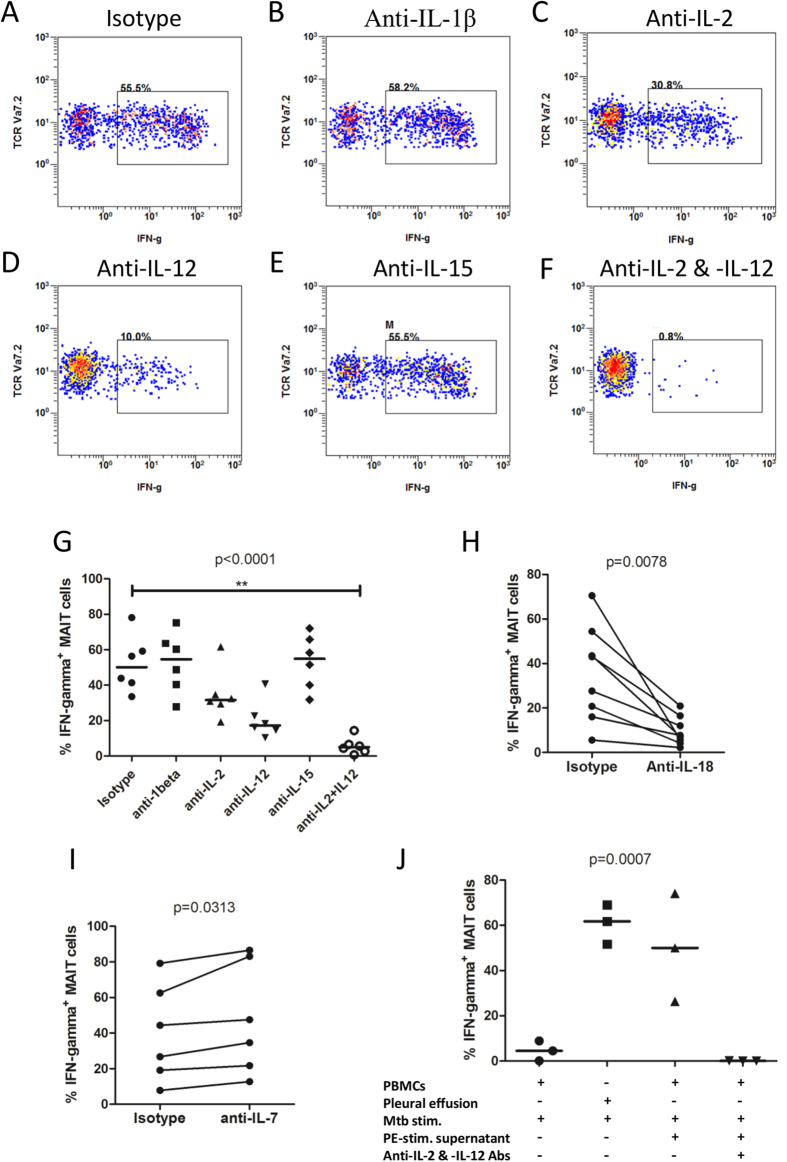
The role of cytokines on IFN-γ response of MAIT cells from tuberculous pleural effusions.(A–F) Representative flow plots showing IFN-γ production in Mtb-stimulated MAIT cells in the presence of isotype antibody control (A), or blocking antibody to IL-1β (B), IL-2 (C), IL-12 (D), IL-15 (E), or combined blocking antibodies of both IL-2 and IL-12 (F). (G) Reduced IFN-γ response in MAIT cells from tuberculous pleural effusions was observed when IL-2 and IL-12 were blocked with antibodies (n = 6). (H) Addition of IL-18 blocking antibody led to decreased IFN-γ production in MAIT cells (n = 8). (I) Blockade of IL-7 resulted in slightly higher IFN-γ response in MAIT cells (n = 6). (J) IFN-γ response in MAIT cells of PBMCs (PBMCs) in the presence of Mtb stimulation and centrifuged supernatants (100 μl) of Mtb antigen-stimulated cells from tuberculous pleural effusions was abolished by blocking antibodies to IL-2 and IL-12 (n = 3). Pleural effusion: mononuclear cells from tuberculous pleural effusions; Mtb stim.: Mtb antigen stimulation; PE-stim. supernatant: supernatants of Mtb antigen-stimulated cells from tuberculous pleural effusions; Anti-IL-2 & IL-12 Abs: combined blocking antibodies to IL-2 and IL-12. The Friedman’s test (p < 0.0001), followed by Dunn’s multiple comparison test was used in Fig. 5G. The non-parametric Wilcoxon signed-rank test was used for statistical analysis between groups in Fig. 5H,I. Kruskal-Wallis test was used for statistical analysis in Fig. 5J. Horizontal bars in the scatter plots indicate medians. **p < 0.01.